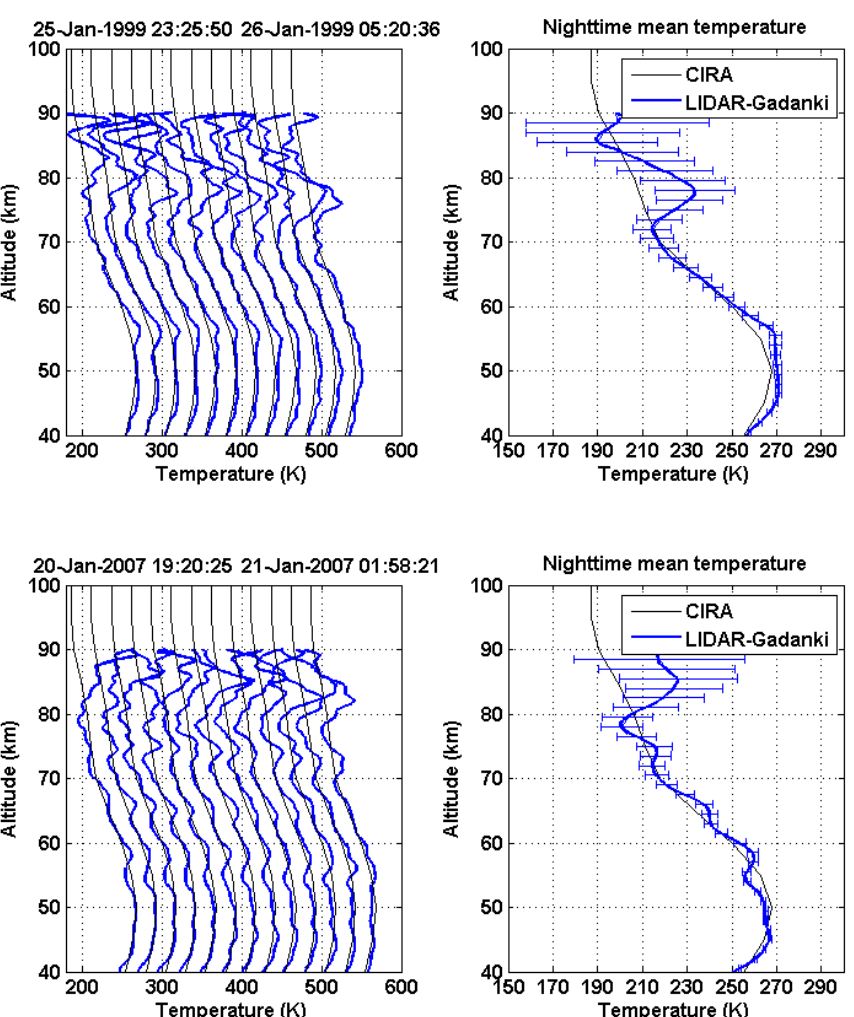
Fig. 6. Rayleigh lidar derived temperature profiles averaged for 30min each (left panels) and nighttime mean temperature (right panels) over